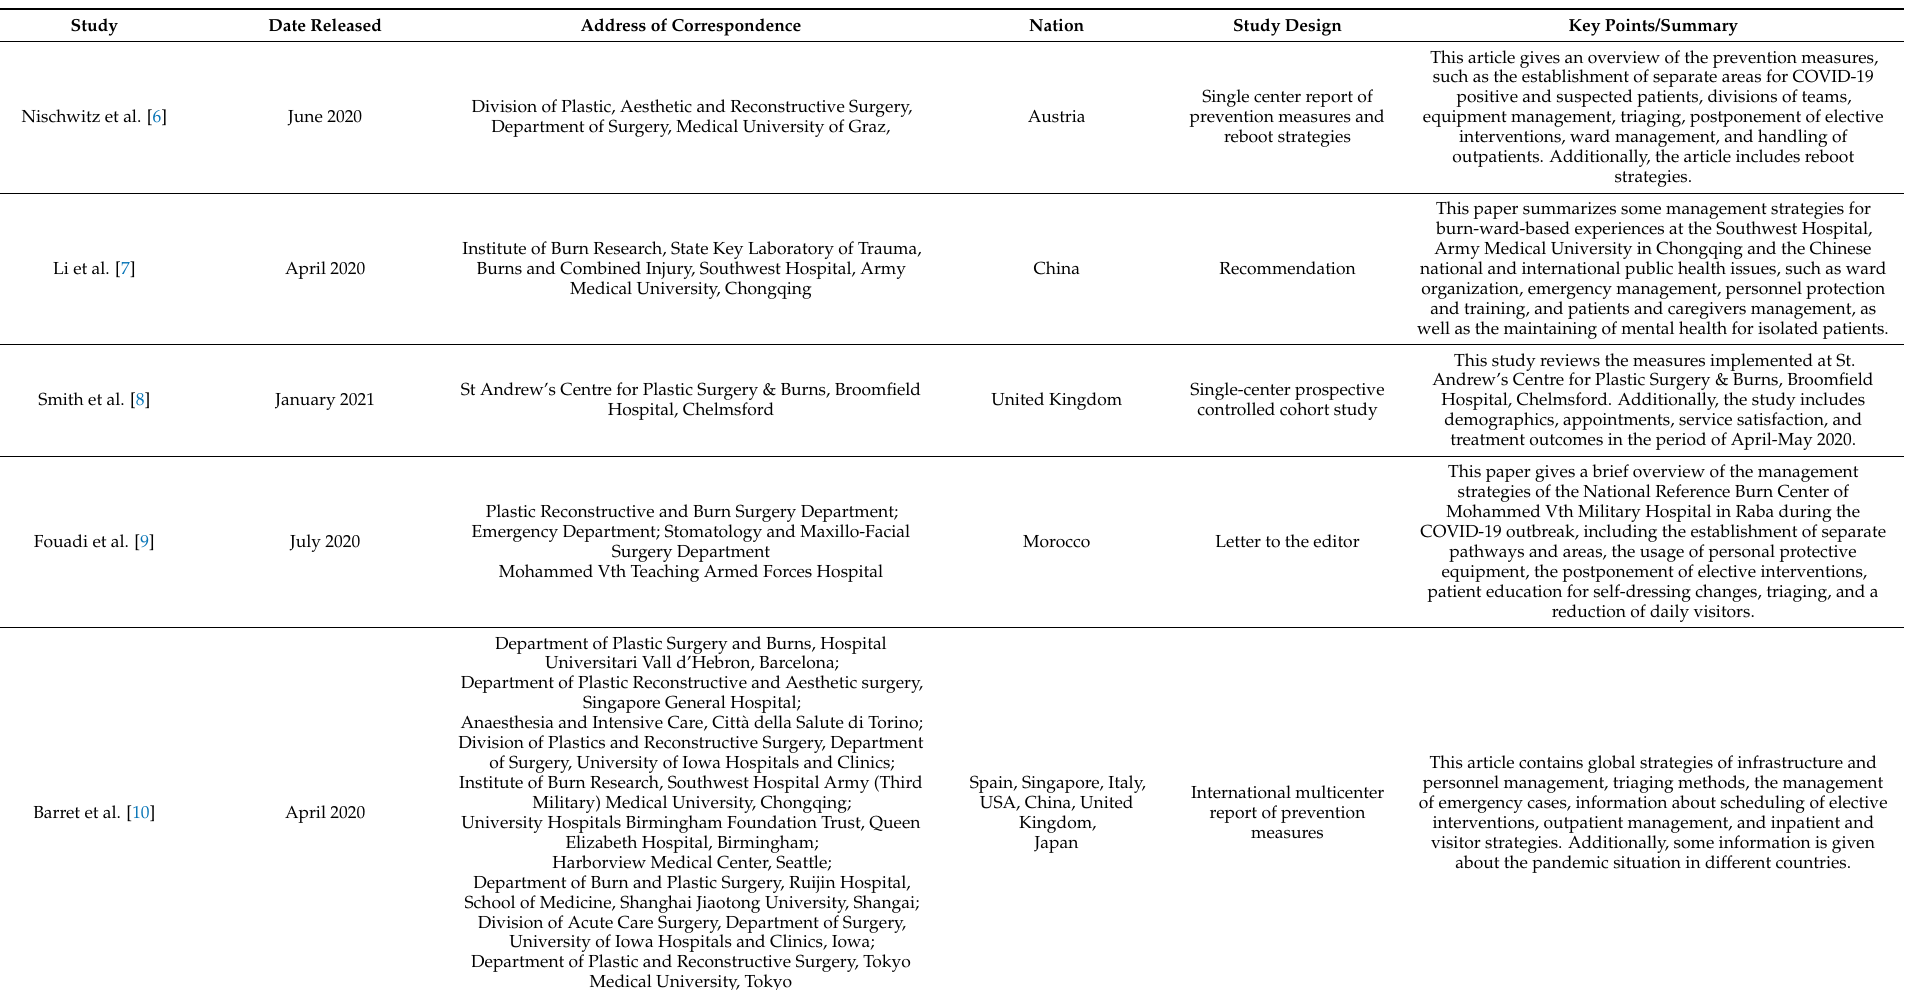
Table 2. An overview of the eligible studies and their key